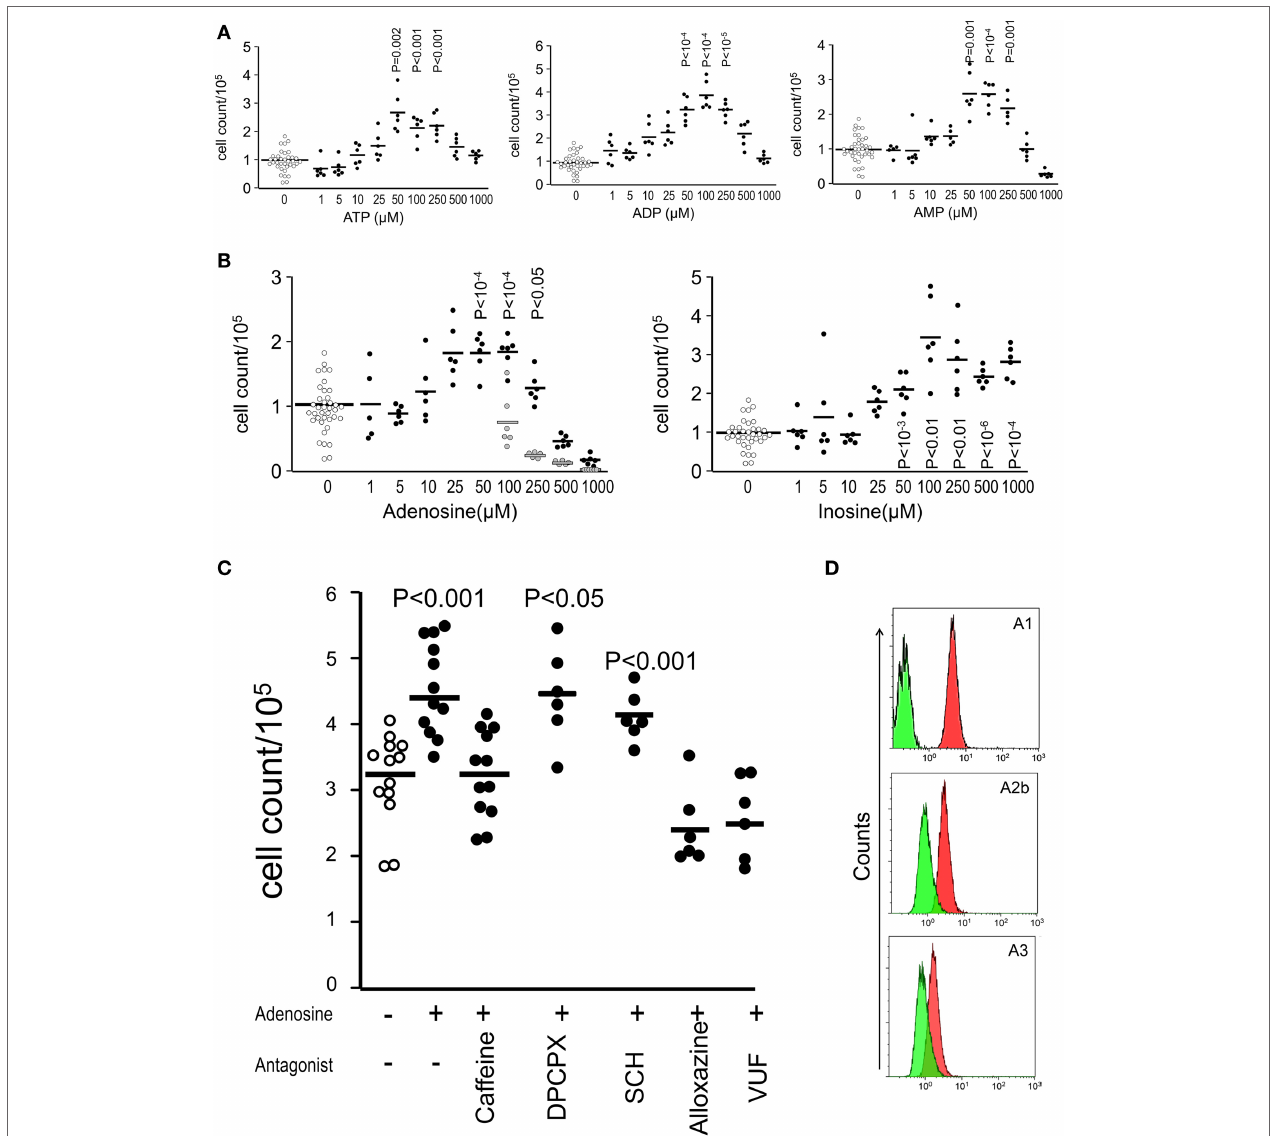
FigUre 4 | adenosine receptors mediate the stimulation of the proliferation induced by supernatants of dead and dying cells . Shown are cell counts of cultures measured by the crystal violet method for adherent cells at day 9 showing the relative potency of nucleotides (a) and nucleosides (B) on the stimulation of proliferation of B16F10 melanoma cells (D10 medium wells are open circles, purinergic metabolites are closed circles, and vehicles for adenosine are gray circles). The pan-adenosine receptor antagonist caffeine and the specific adenosine receptor antagonists alloxazine (A2bR) and VUF (A3R) blocked the stimulation of proliferation induced by inosine (c) . Adenosine receptor expression on B16F10 cells (D) . Green represent the isotype antibody binding and red the receptor